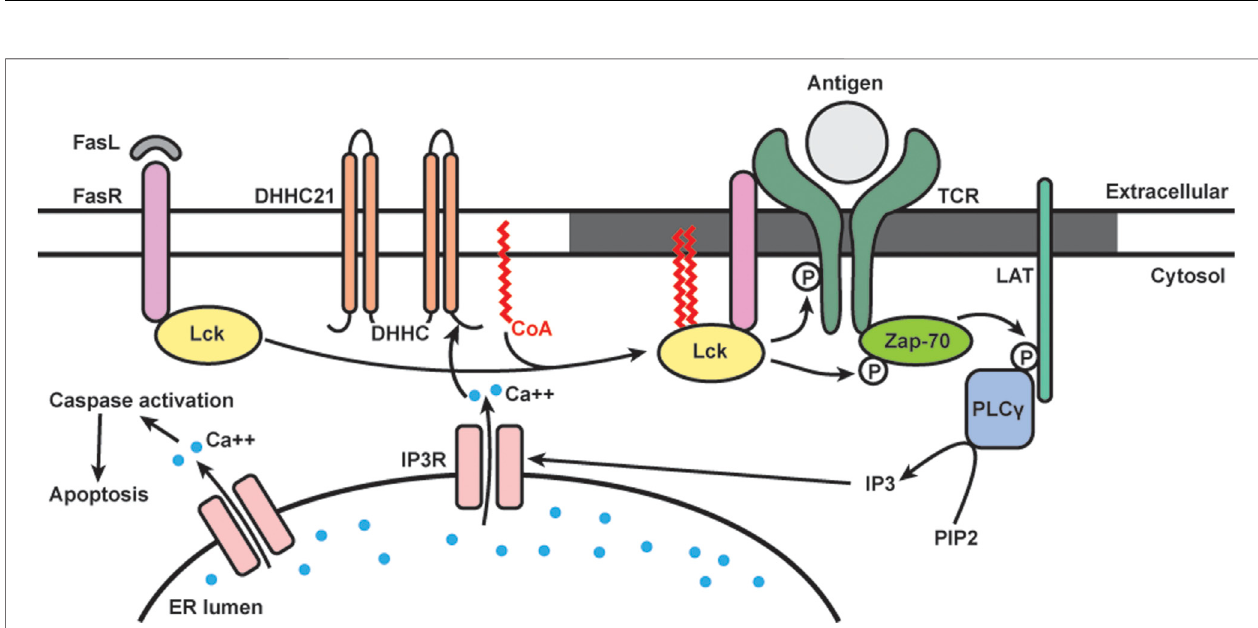
FIGURE 3 | Schematics of dynamic S-acylation of Lck in T cells. Upon Fas receptor (FasR) activation by Fas ligand (FasL), DHHC21 palmitoylates Lck, which localizes it to lipid raft (grey) to activate the TCR signaling complex. Downstream calcium (blue) release from ER leads to apoptosis.